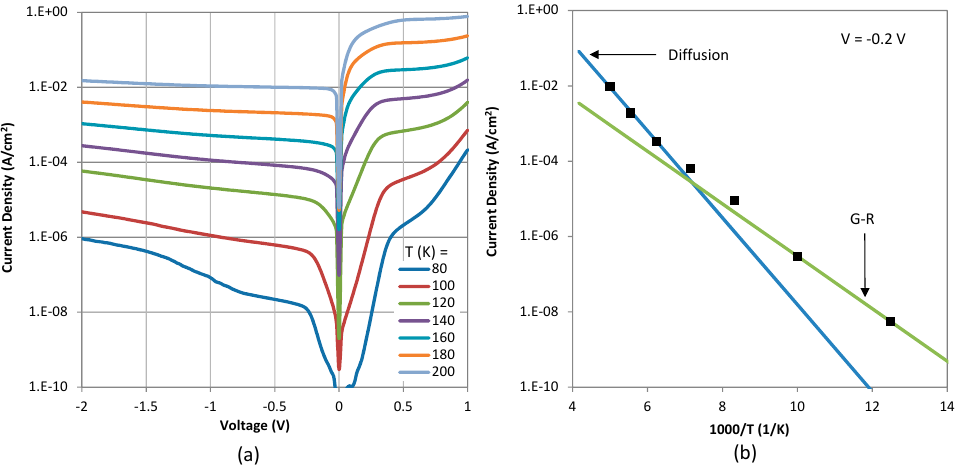
Figure 3. ( a ) Dark current-voltage-temperature (IVT) characteristics of a 400 × 400 µ m size n B n detector and ( b ) Arrhenius plot at a bias voltage of –0.2 V. The linear fit to the current at T > 160 K yields an activation energy of 203 meV.